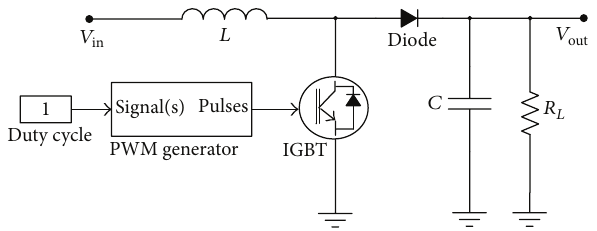
Figure 3: Circuit diagram of the boost converter.